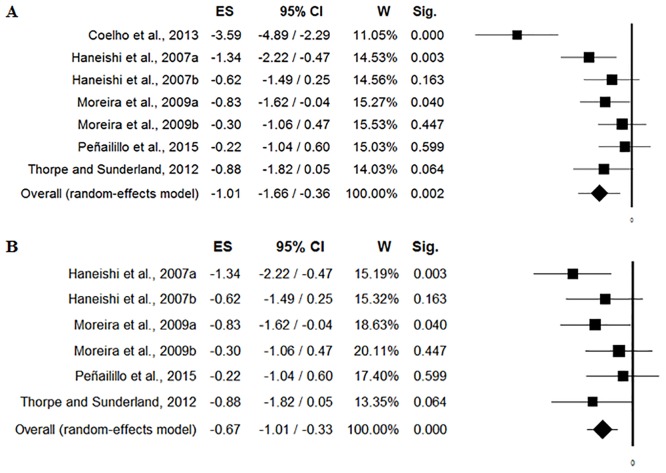
Forest plot of cortisol [nmol/L] changes induced by soccer match, including (2a) and removing (2b) Coelho et al. [29].